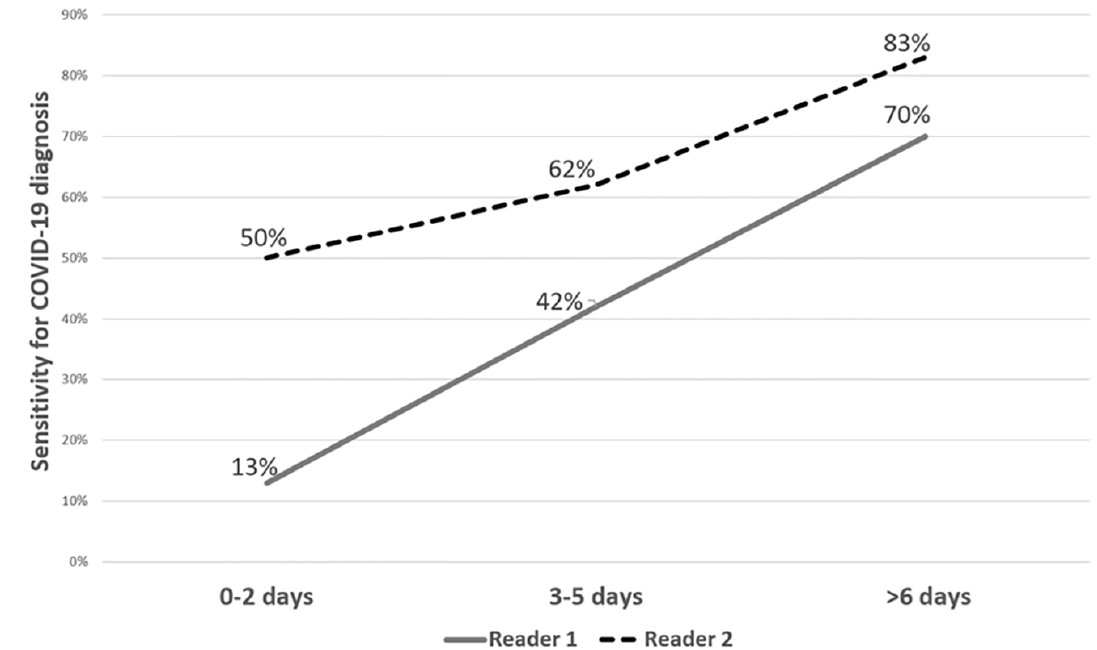
Figure 3. Sensitivity for RALE score threshold of 5 for the diagnosis of coronavirus disease 2019 in patients presenting at different timeframes from symptom onset.